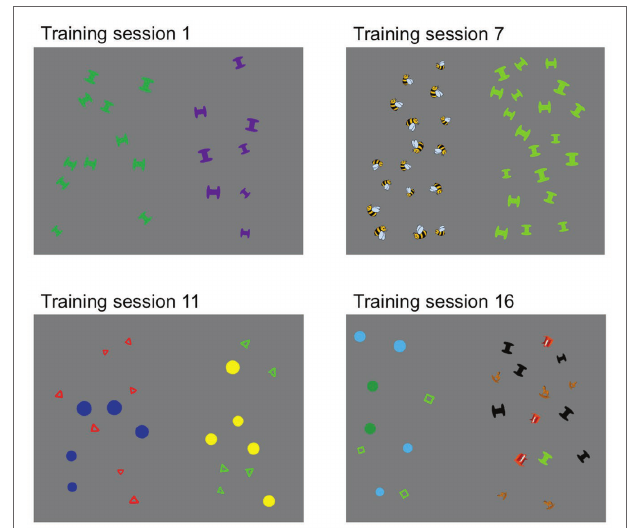
FIGURE 1 | Sample stimuli from four representative visual approximate number system (ANS) training sessions, illustrating the increasing complexity of the stimuli. Children were asked to indicate whether the array on the left or the right had more